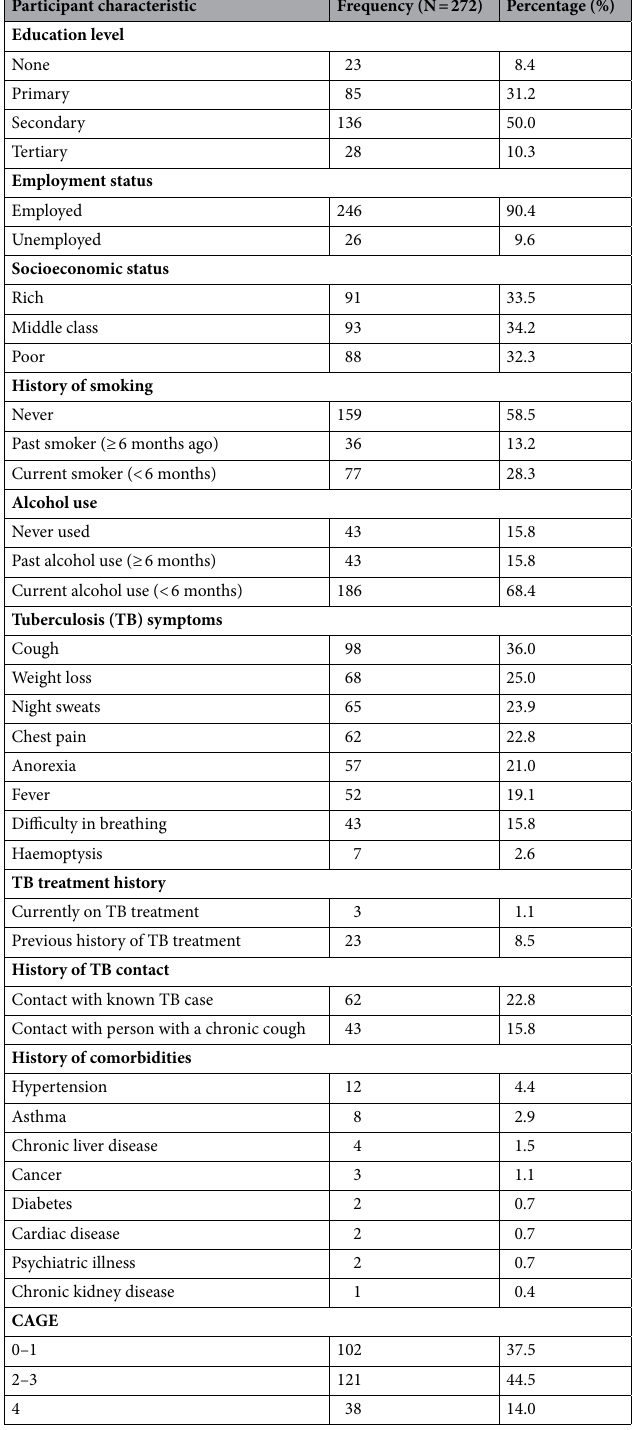
Table 1. Characteristics of study